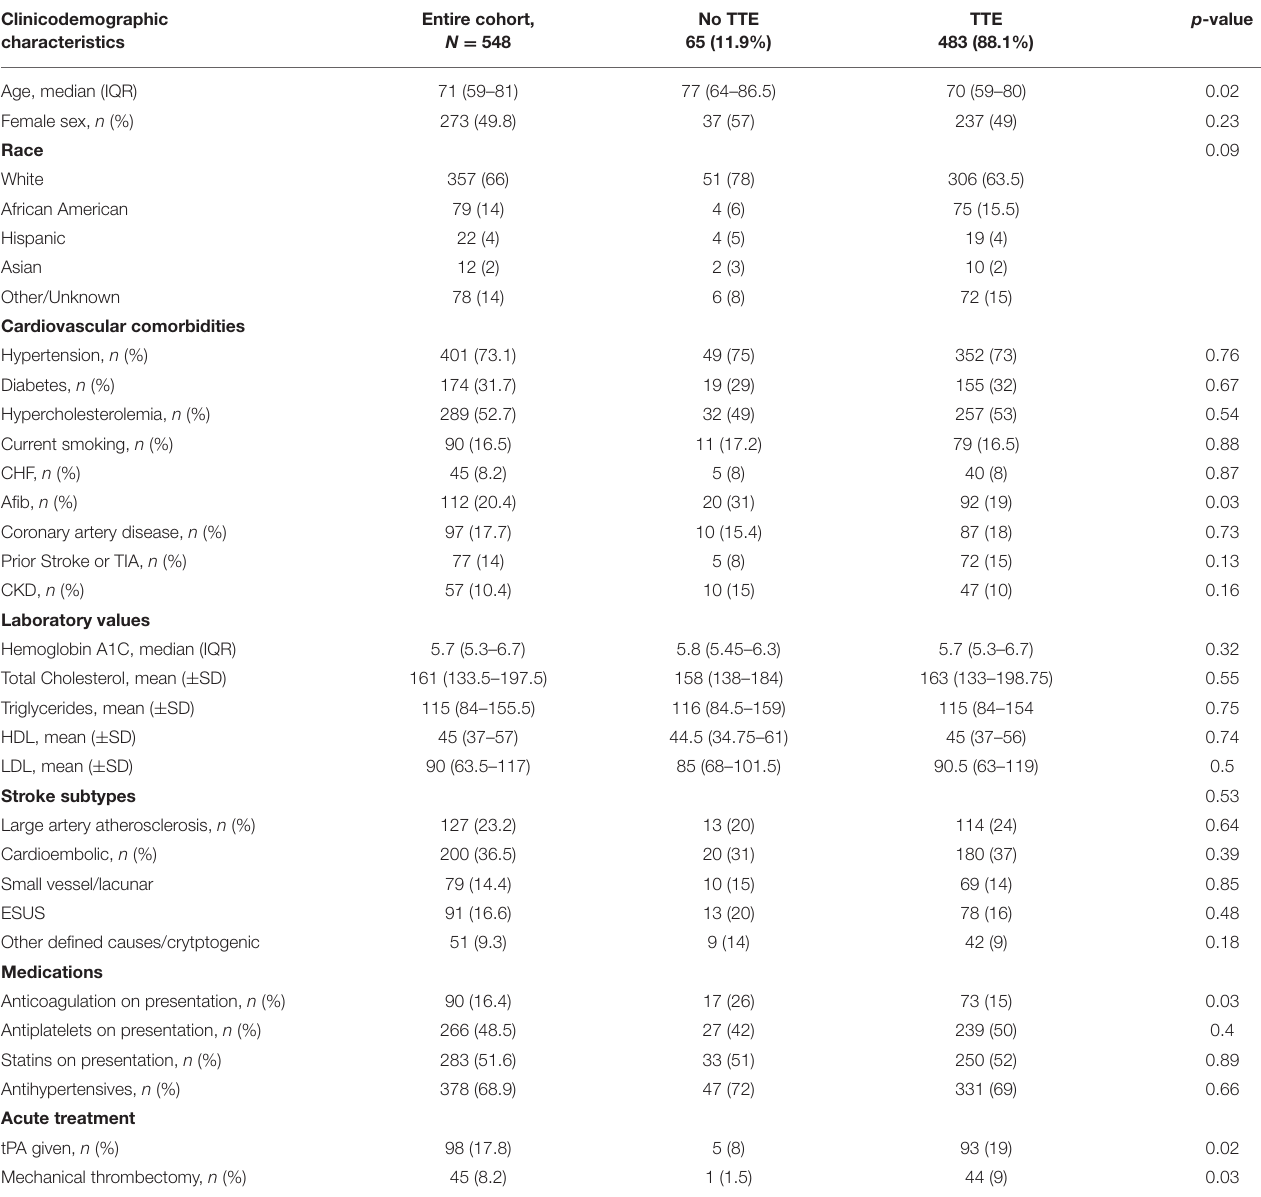
TABLE 1 | Summary of baseline cohort